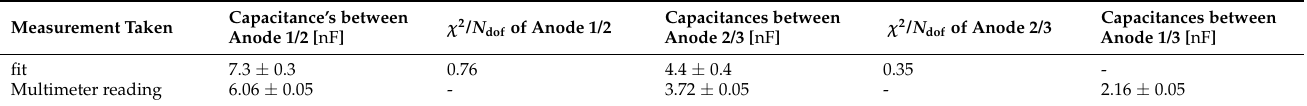
Table 4. Mesh capacitances determined by a fit [29] and by a direct measurement with a multimeter. Measurement Taken Capacitance’s between Anode 1/2 [ nF